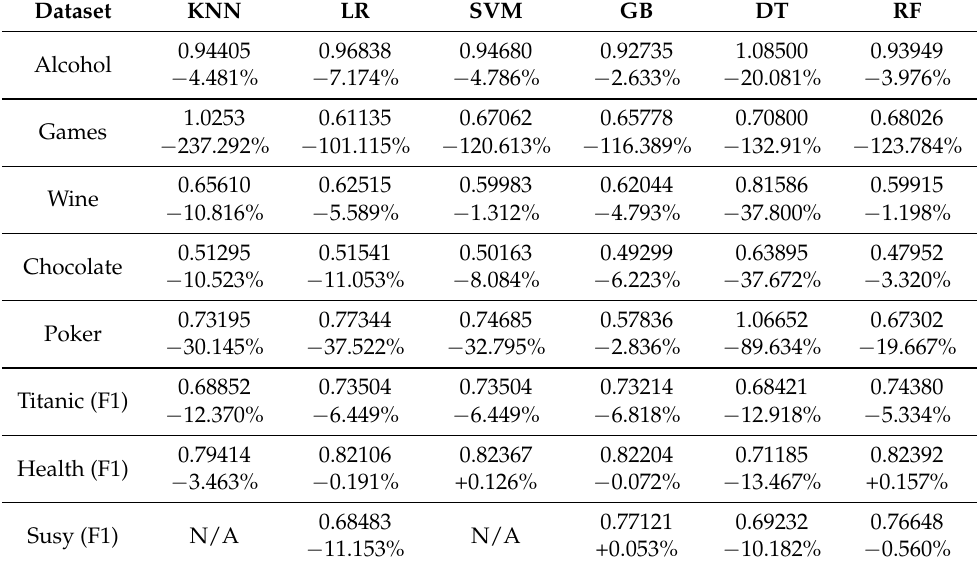
Table 5. Comparison of different models to the original tabular model in Table 4, top is RMSE/F1 depending on the dataset and bottom is the difference in percentage compared to the original tabular model. Note that the pruned tabular models are not reflected in these results and the difference is only computed for original. We have two missing results for Susy due to the size of the train/valid/test set as KNN and SVM are too inefficient to compute these scores. Dataset KNN LR SVM